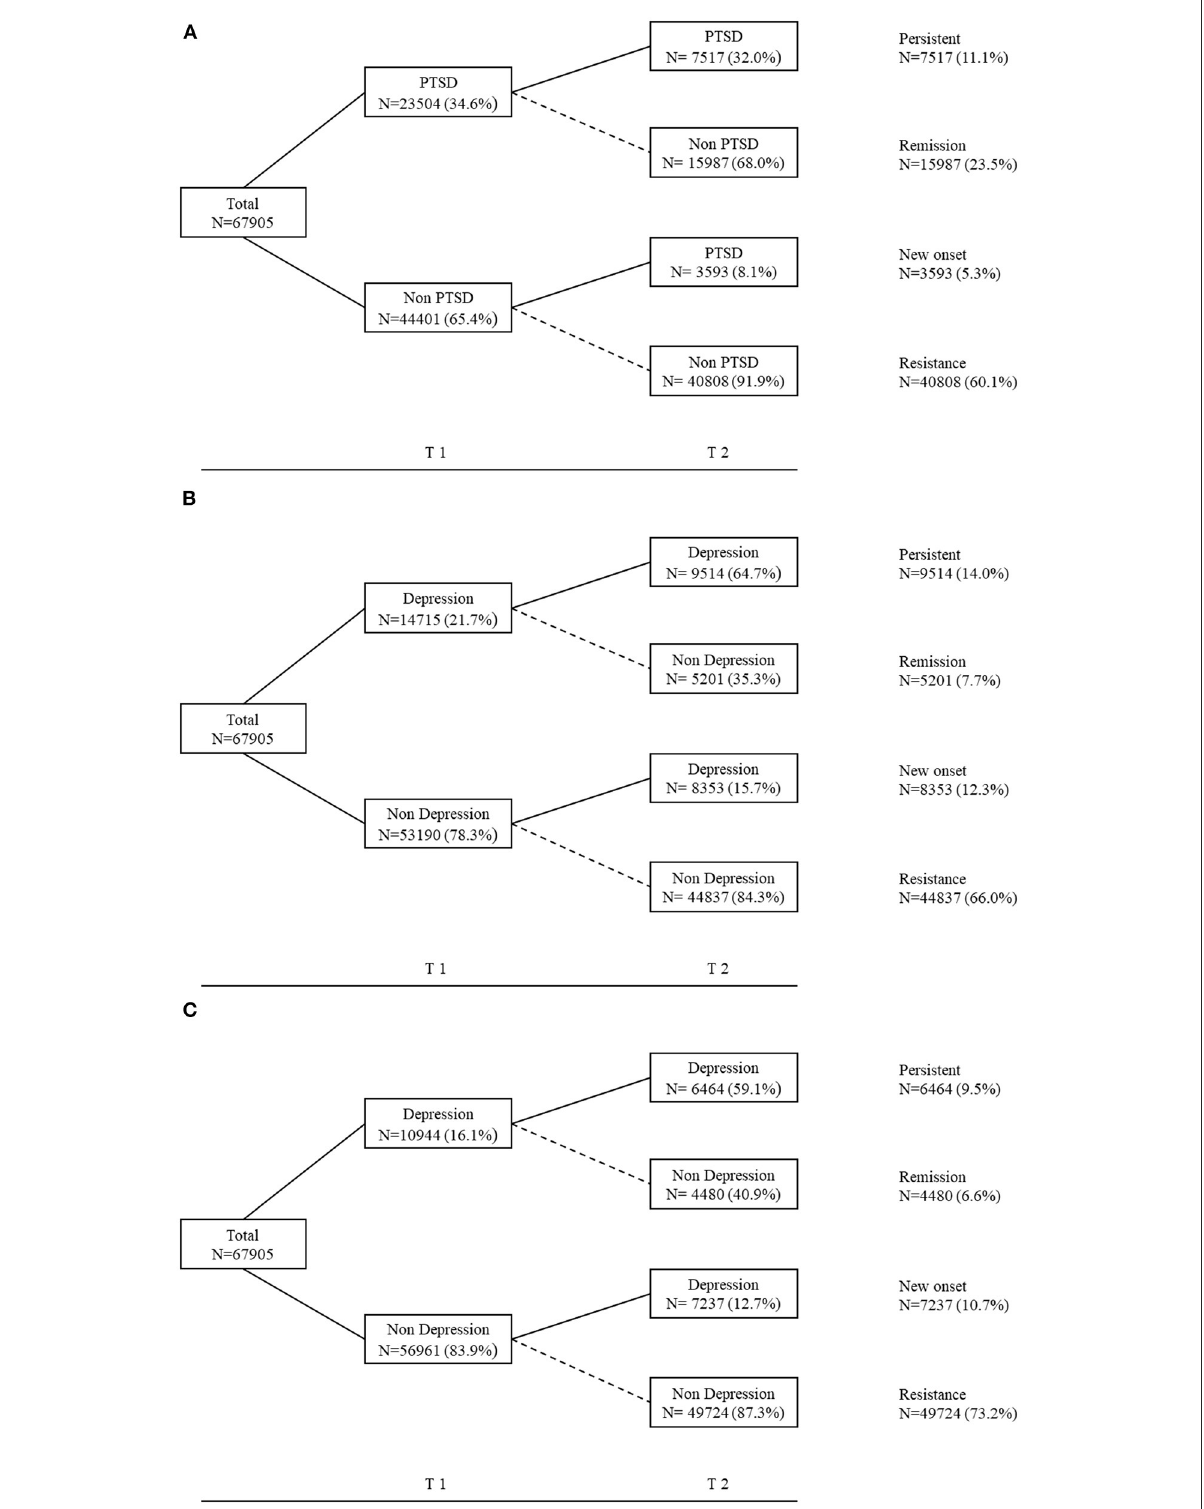
FIGURE3 Trajectory changes of mental health problems among colleges students during the pandemic. (A) The trajectory of PTSD; PTSD calculated using the IES-6, with a clinical cut-off score of 1.5. (B) The trajectory of depression; Depression calculated using the PHQ-9, with a clinical cut-off score of 7. (C) The trajectory of depression; Depression calculated using the PHQ-8 (exclude the sleep-related item), with a clinical cut-off score of